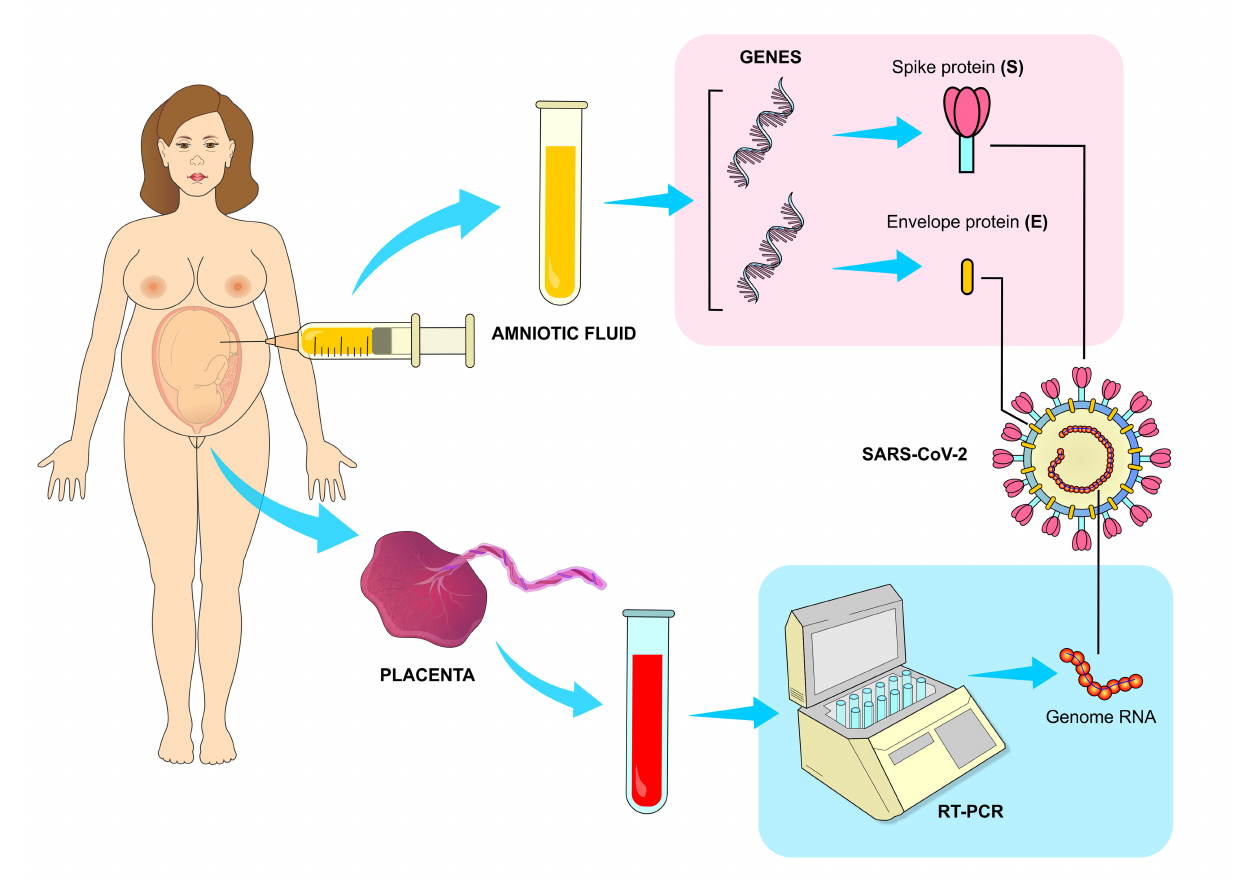
FIGURE 9 | Vertical transmission of SARS-CoV-2. The transmission of the virus from infected mothers to fetus has been confirmed by RT-PCR (Reverse Transcription Polymerase Chain Reaction) method, which has detected a high viral load in the placenta. The presence of viral genes responsible for translating structural proteins E and S were also detected in samples of amniotic fluid collected during cesarean surgeries of infected